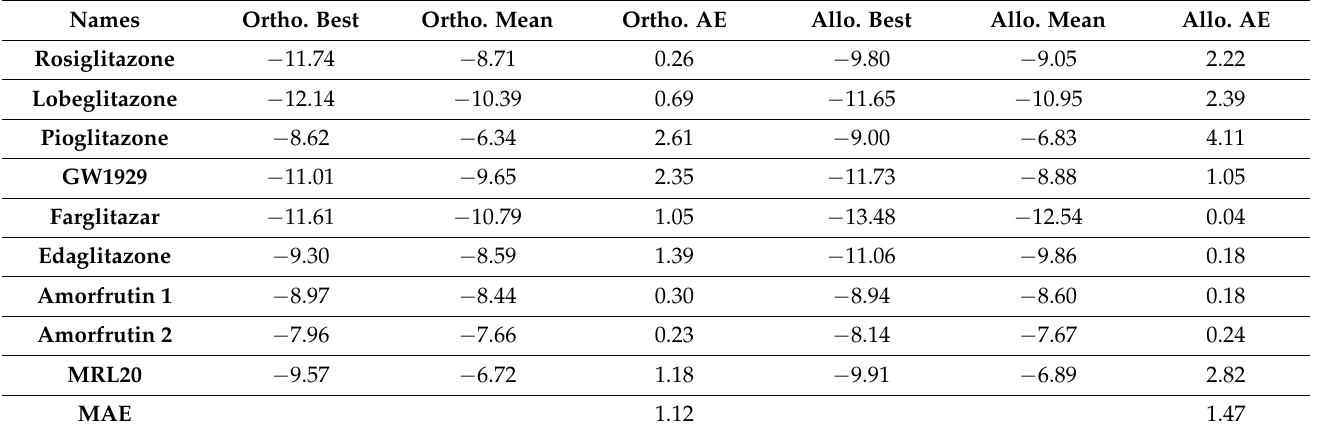
Table 6. The glide scores (kcal/mol) (the best docked pose and the average of the top five poses) and the absolute errors (AE) between the average top 5 IFD-glide scores and the respective Glide Dock glide scores for the nine PPAR γ agonists against the allosteric and orthosteric binding